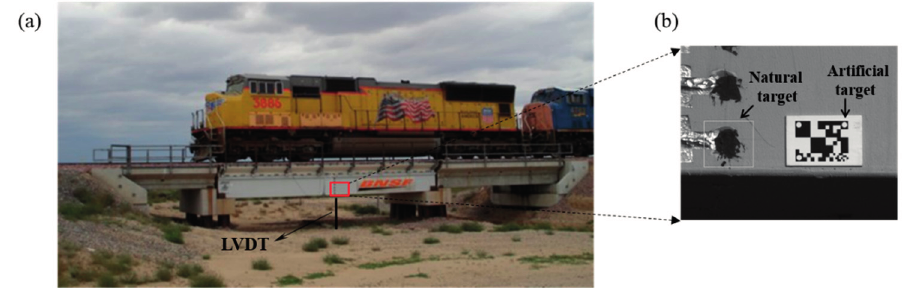
Figure 11. Field test of a railway bridge: ( a ) Displacement measurement under moving trainloads; ( b ) Artificial target and natural